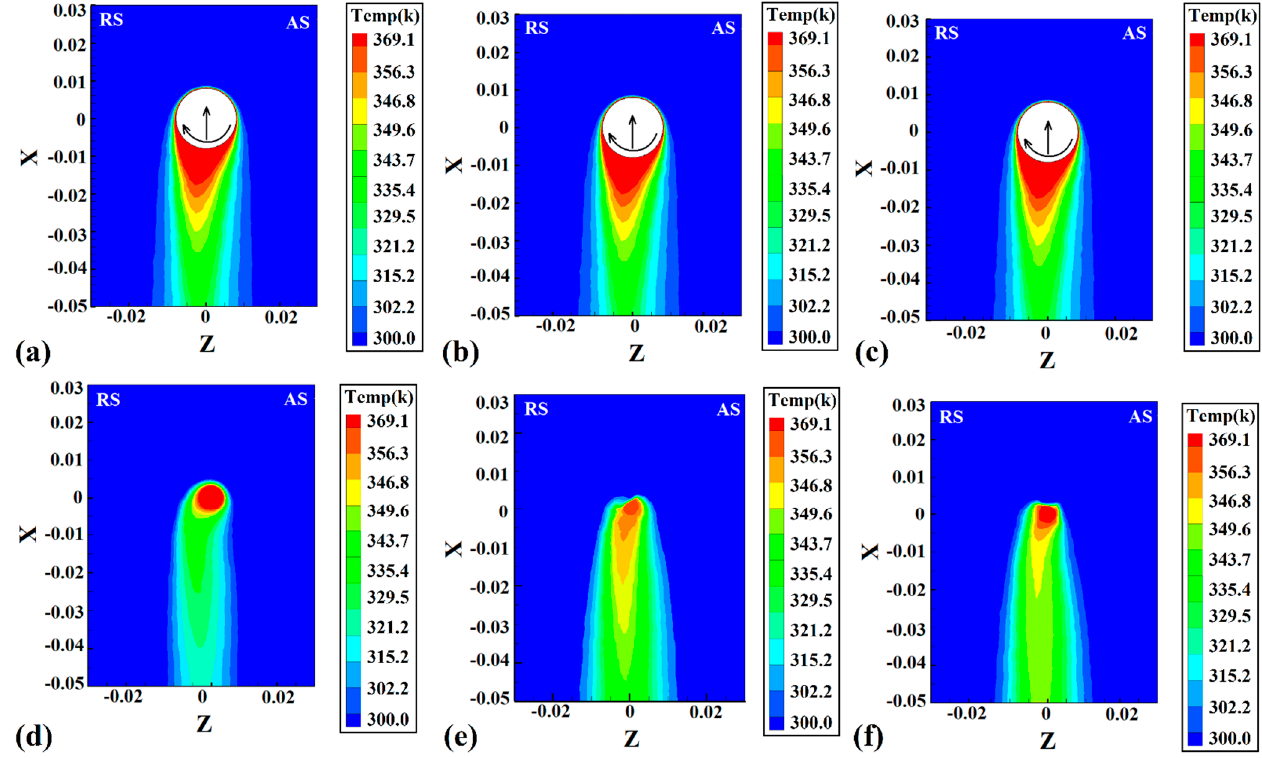
Figure 7. Simulation results of surface heat flow at joint FSWed by ( a ) FPT, ( b ) TPT, and ( c ) CPT pins. Simulation results of backplate heat flow at joint FSWed by ( d ) FPT, ( e ) TPT, and ( f ) CPT pins.